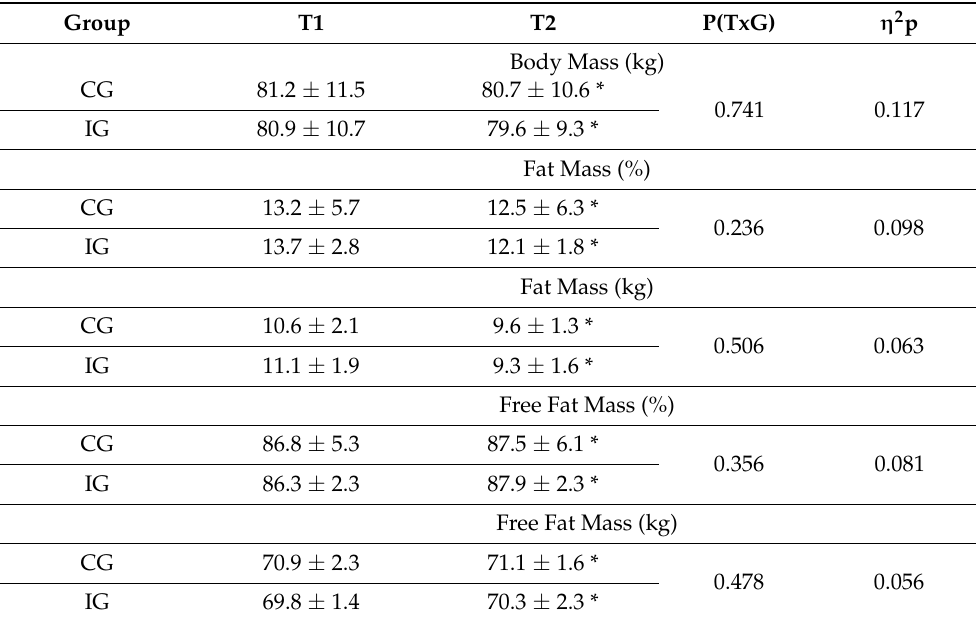
Table 3. Body composition in the control group (CG) and intervention group (IG) at baseline (T1) and after 6 weeks (T2).